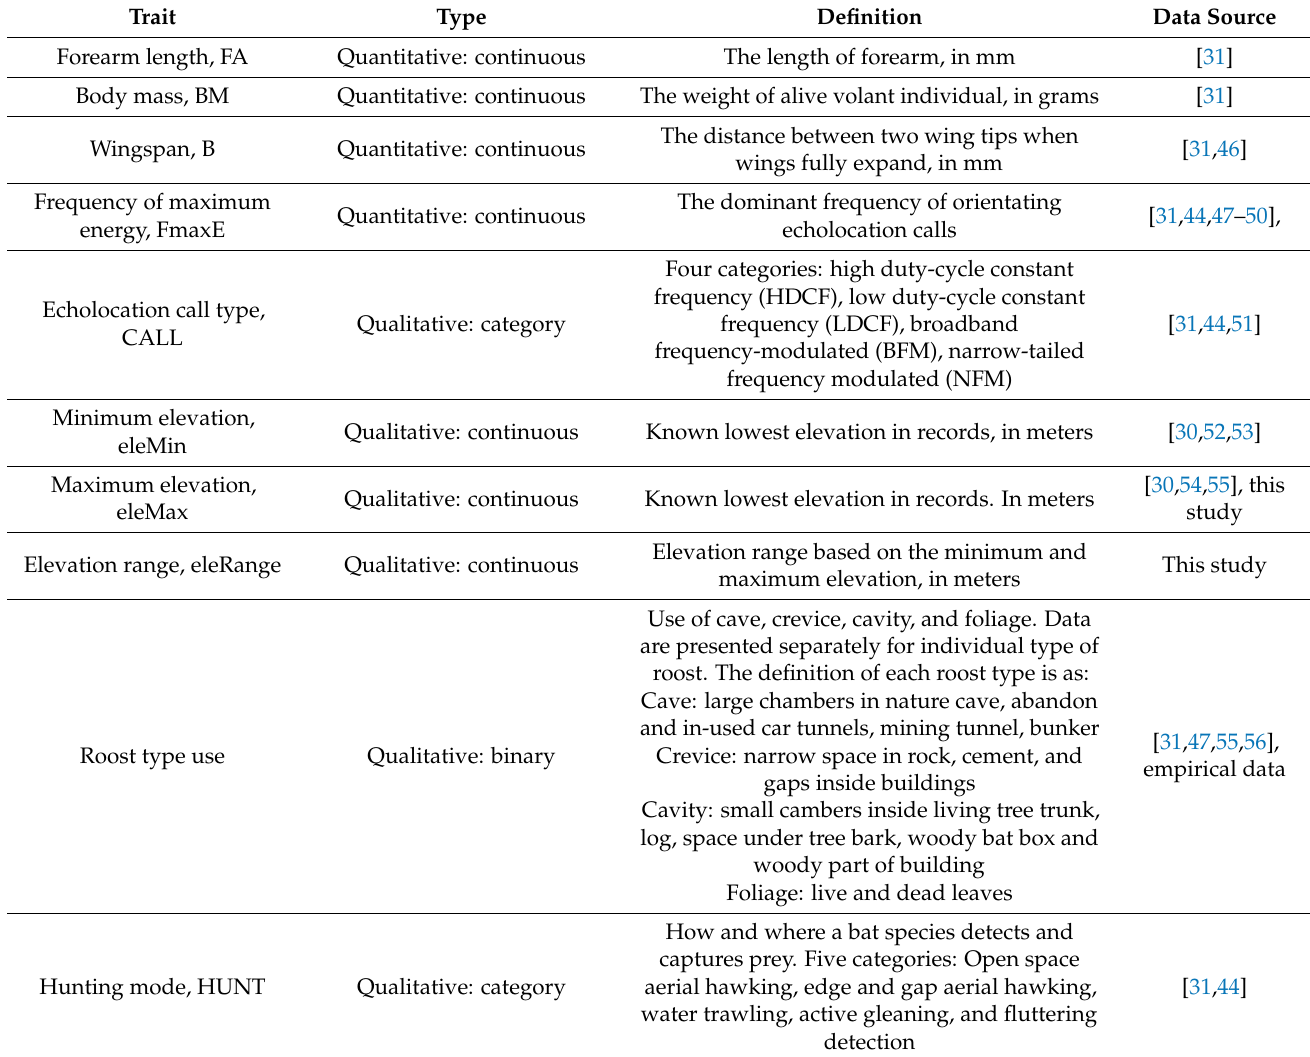
Table 1. Ten ecomorphological traits used in the present